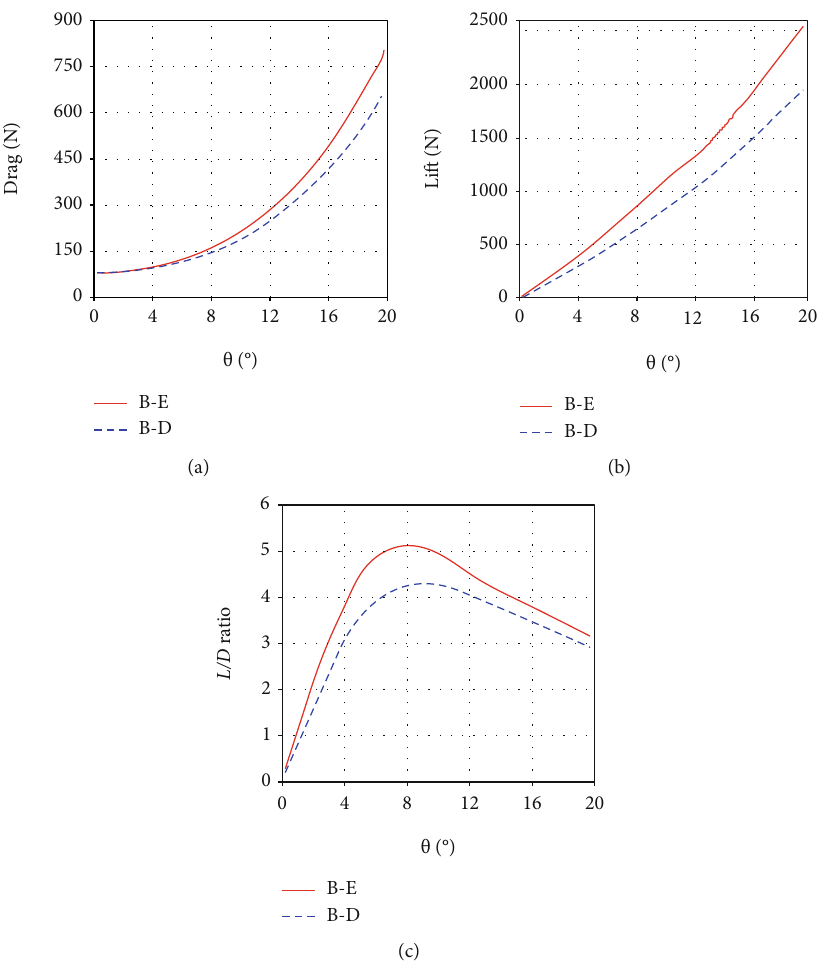
Figure 8: The drag, lift, and L / D ratio of the tuna body in the erection and depression states under the quasi-static yaw motion ( ω = 0 : 01 rad/s): (a) the drag of the body; (b) the lift of the body; (c) the L / D ratio of the body. Note: B-E (or B-D) represents the hydrodynamic force of the body (B) when all median fi ns are erected (or depressed).